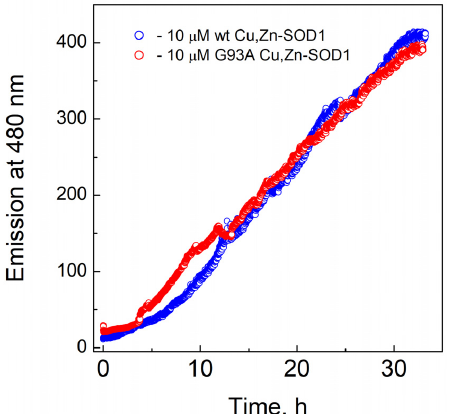
Figure 5. Demetallation of wt Cu,Zn-SOD1 and of its G93A mutant in the absence of EDTA monitored by LC-ICP-MS. ( A ) fraction of Cu bound to SOD1; ( B ) fraction of Zn bound to SOD1; ( C ) Arrhenius plots for the de-coppering of wt and G93A mutant Cu,Zn-SOD1. Conditions: 10 µ M wt Cu,Zn-SOD1 (blue symbols) and 10 µ M of its G93A mutant (red symbols) in 50 mM HEPES/50 mM NaCl, pH 7.3 at 60 ◦ C, 70 ◦ C and 80 ◦ C. EDTA at 1mM concentration was added to the samples before LC to obtain the LMW peak. 2.3. Fibrillization of Cu,ZnSOD-1 and Its G93A Mutant Fibrillization of Cu,Zn-SOD1 and its G93A mutant at 40 ◦ C are presented in Figure 6, which demonstrates that both proteins exposed similar fibrillization kinetics.